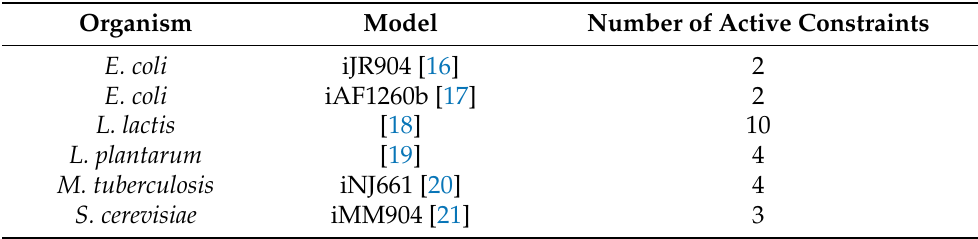
Table 1. Published genome-scale models often have several active constraints on reaction rates. A constraint is active when it has a nonzero reduced